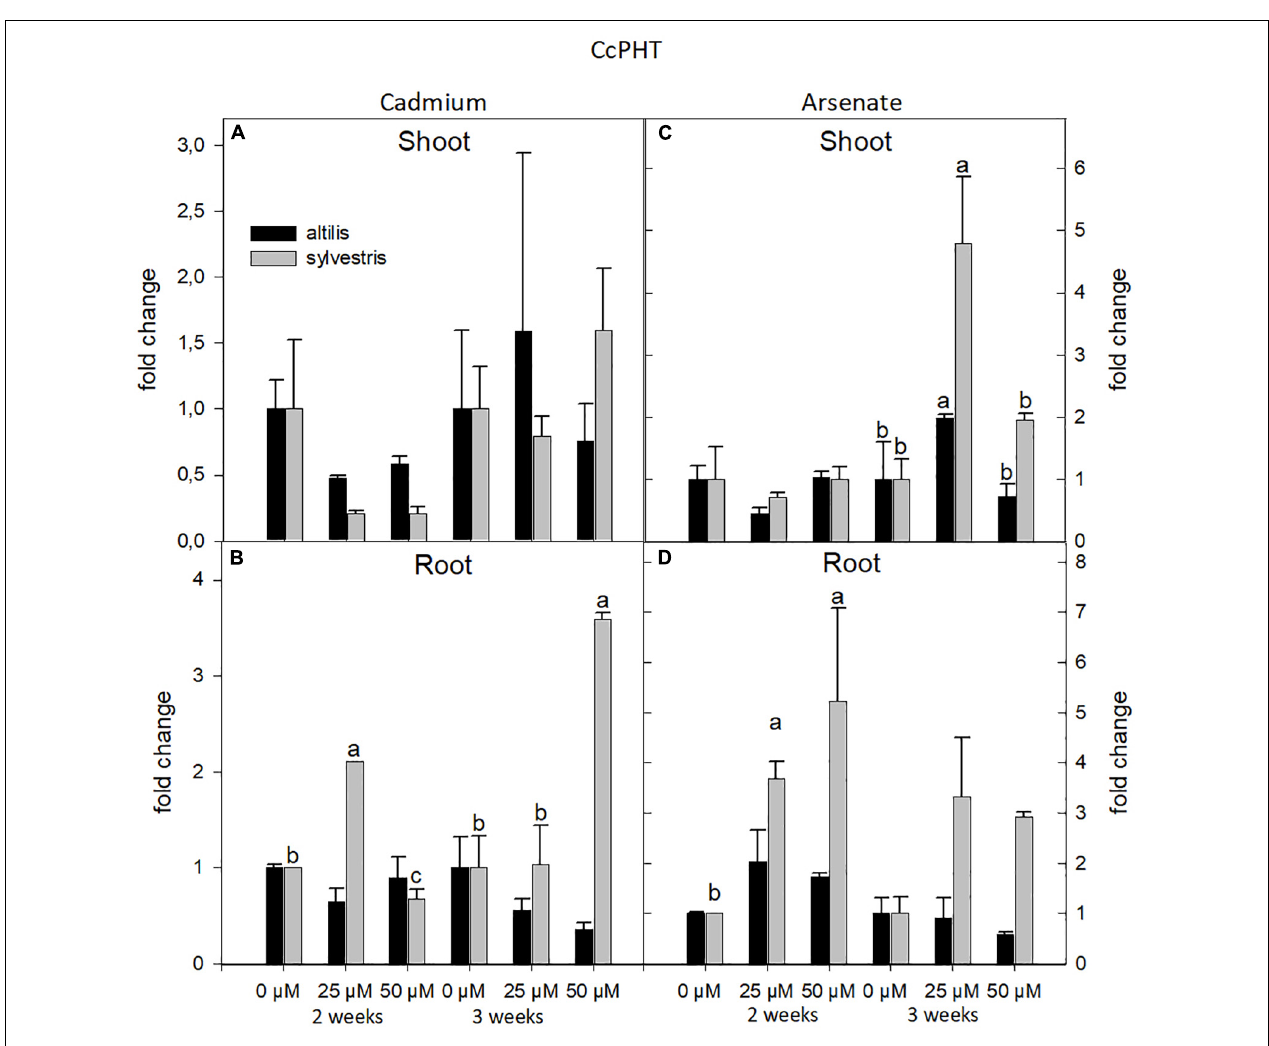
FIGURE 7 | The level of gene expression of PHT in seedlings of altilis and sylvestris grown up to 2 and 3 weeks under Cd (A,B) and As (C,D) at different concentrations. The fold change is the Ct value with respect to the housekeeping genes (EF1 α and GAPDH) that is considered 1. The error bars represent the error mean of three biological replicates. Letters indicate only significantly different values ( P ≤ 0.05) between concentrations in each moment of sampling.